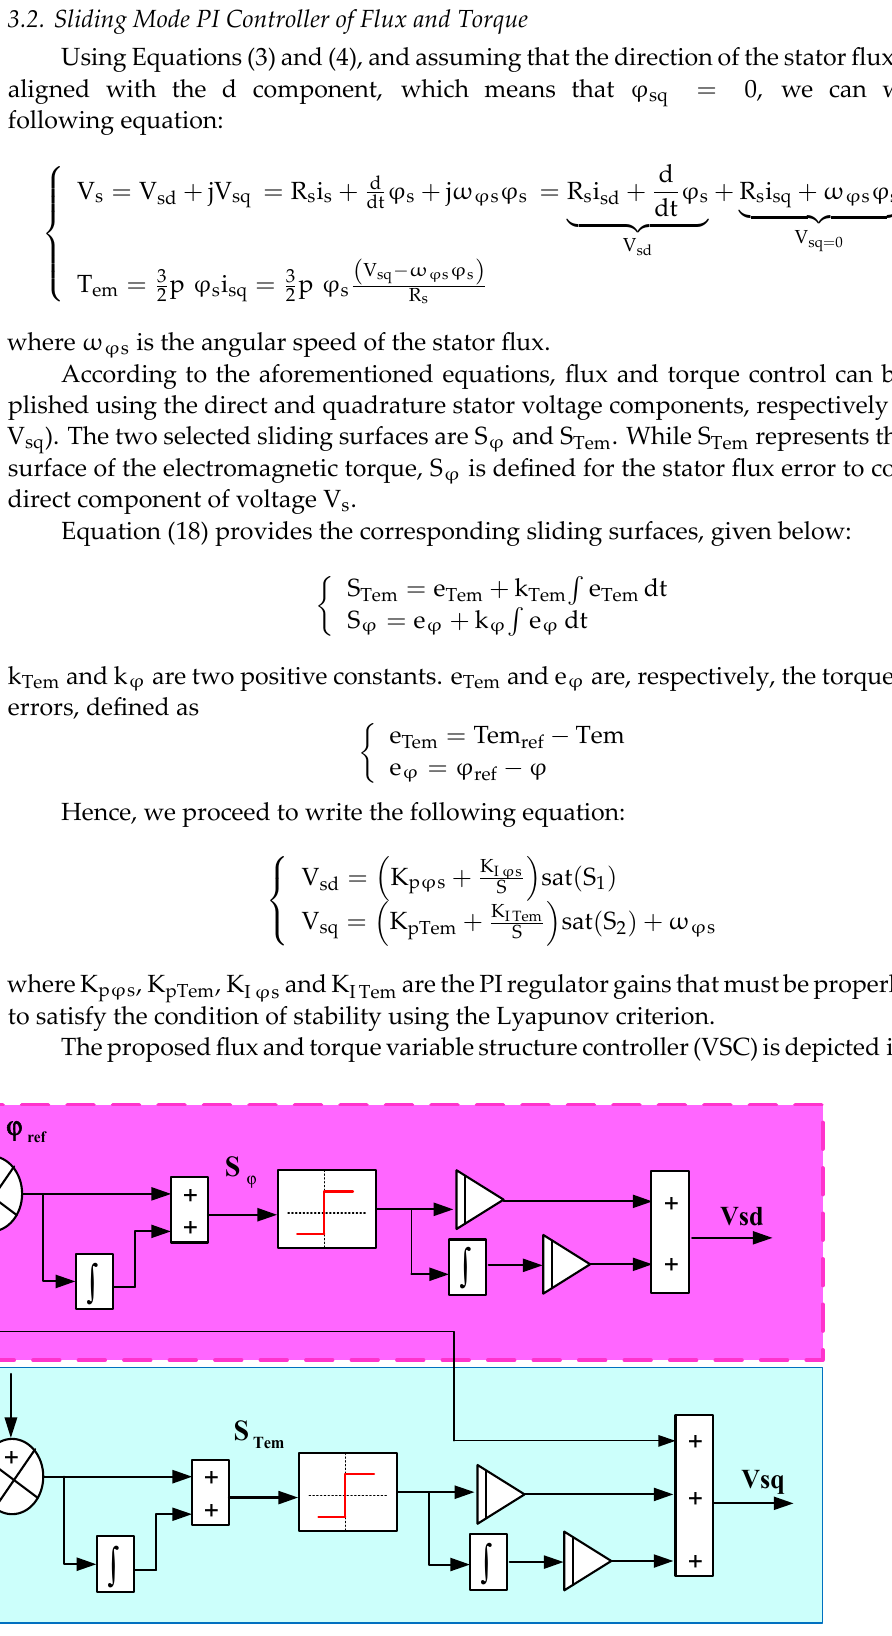
Figure 5. SM − PI flux and torque regulation. Figure 5. SM‑PI flux and torque